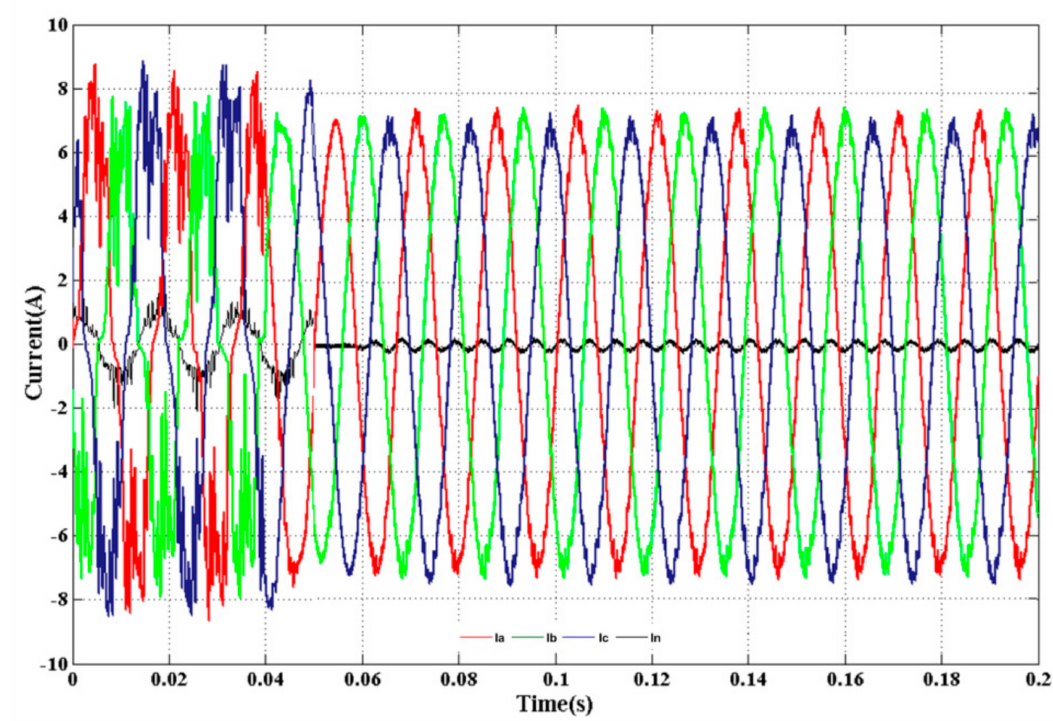
Figure 13. Experimental result of the RNN for case